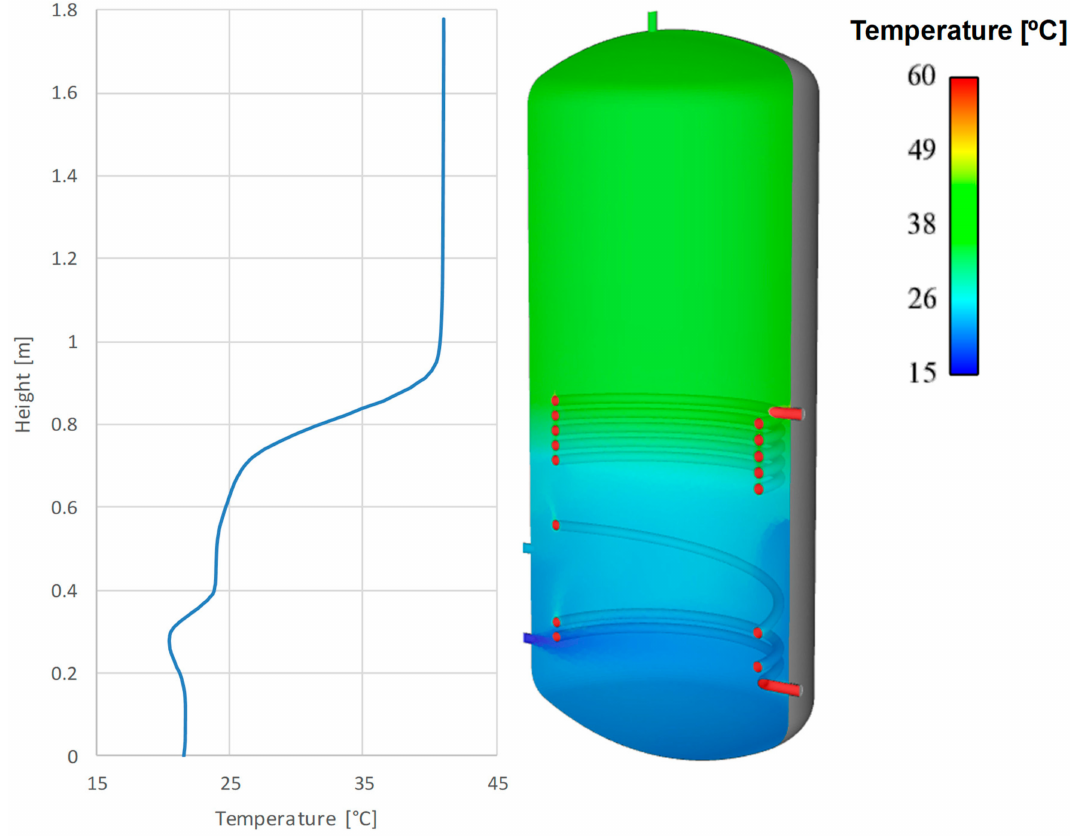
Figure 2. Temperature field in the tank.